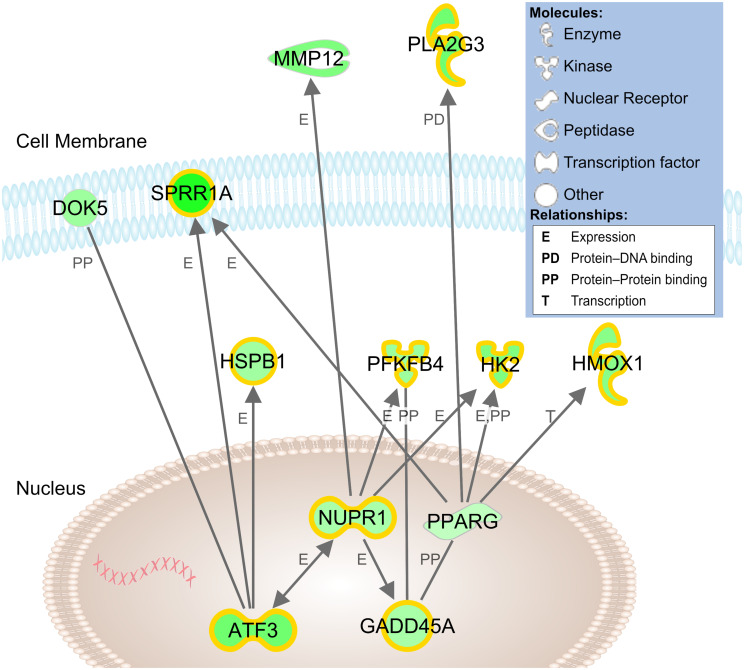
Network model of cDNA microarray findings in stretch-grown DRG neurons. Connections between genes reflect relationships established in literature and identified by Ingenuity Pathway Analysis software. Green shading reflects level of upregulation of stretch-grown samples relative to sham; highlighting reflects significant qRT-PCR validated findings. Gene locations are approximate based of expected subcellular localization established in literature.